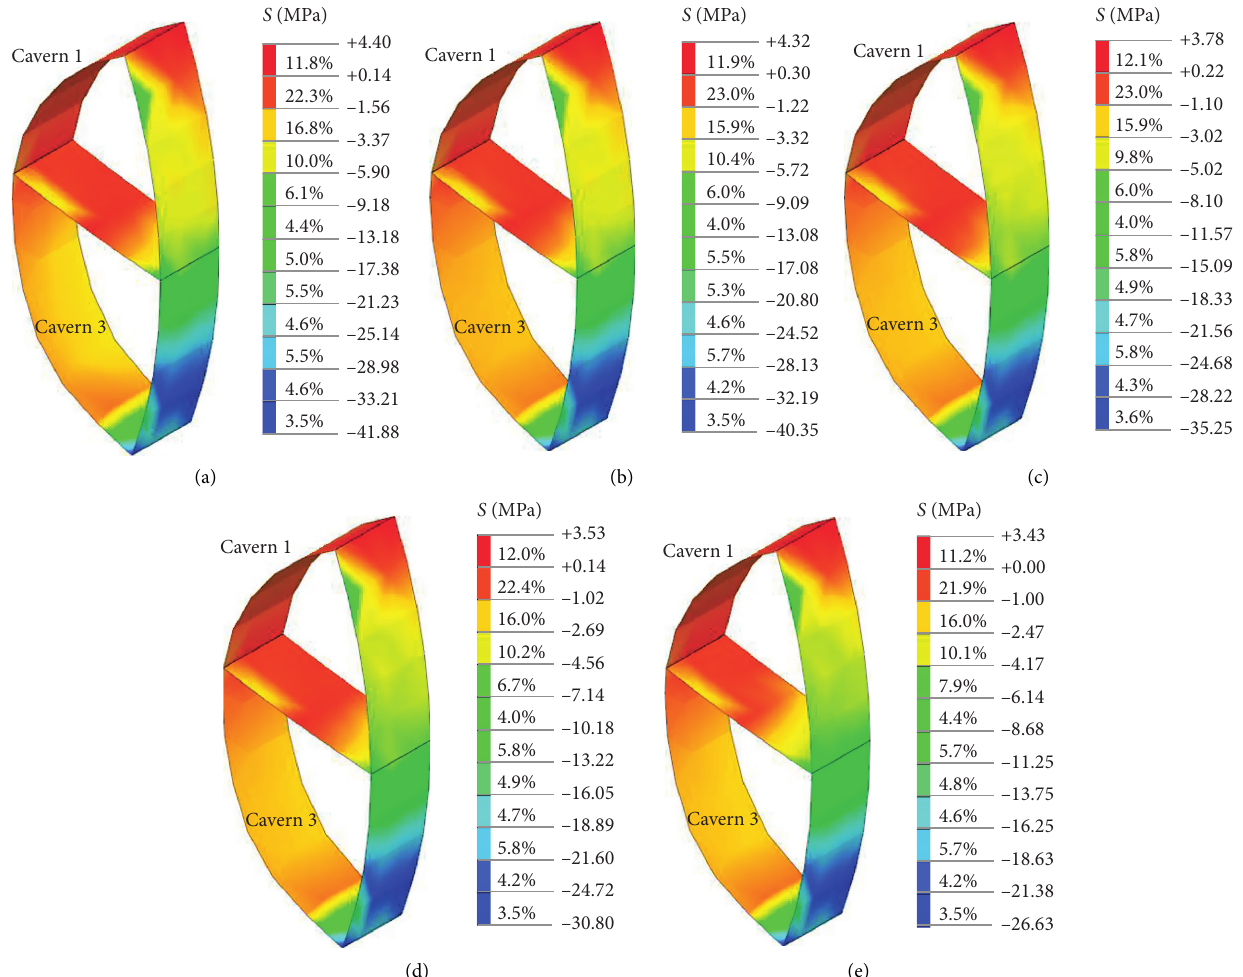
� 2 m, (b) L � 4m, (c) L � 9 m, (d) L � 13m, 2 2 2 2